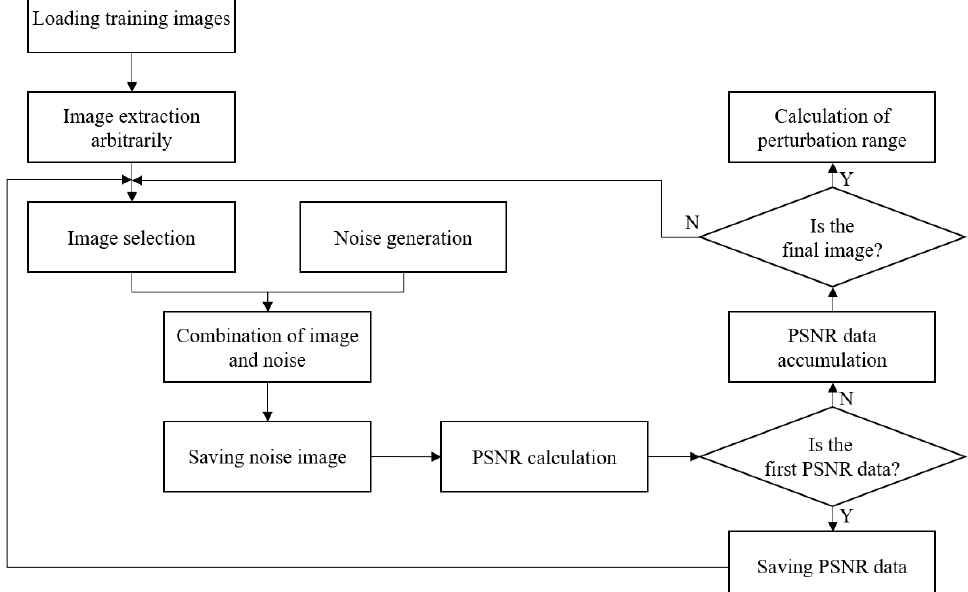
Figure 3. Process of perturbation range